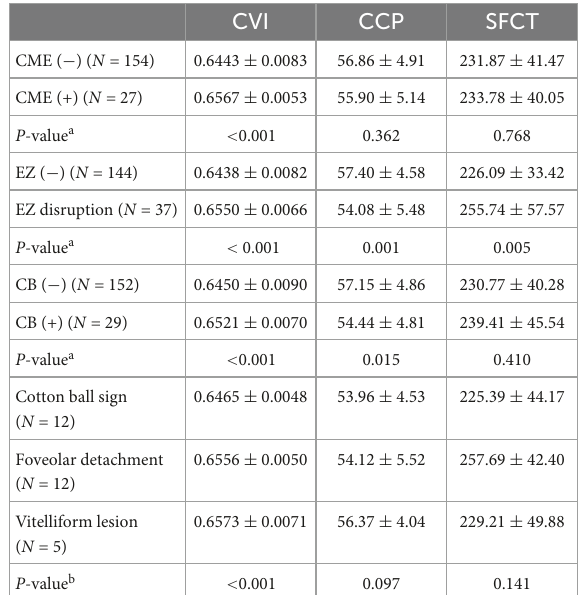
TABLE 3 Distributions of choroidal parameters including CVI, CCP, and SFCT in iERMs eyes in terms of different structural retinal